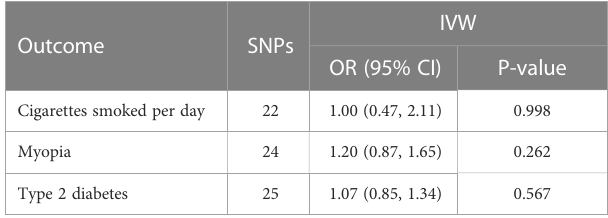
TABLE 3 MR results between AS and confounding factors.